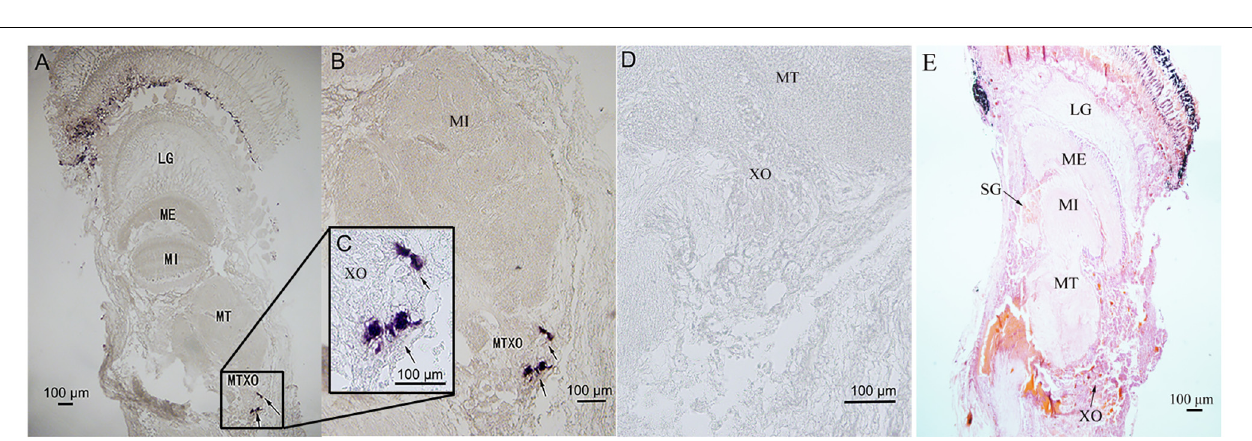
FIGURE 4 | (A) Tissue distribution of Sp-CFSH in both sexes of prepubertal mud crab S. paramamosain . The analysis was generated by PCR assays with cDNAs from various tissues of both sexes and compared with arginine kinase ( AK ) gene. 1, eyestalk ganglion; 2, thoracic ganglion; 3, cerebral ganglion; 4, stomach; 5, ovary or testis; 6, hepatopancreas; 7, heart; 8, hemocytes; 9, muscle; 10, Y-organ; 11, mandibular organ; 12, gill; 13, epidermis; and 14, negative control was shown with the amplification of water. (B) The relative expression of Sp-CFSH between male and female S. paramamosain . Data are shown as means ± SEM of six separate individuals ( n = 6).